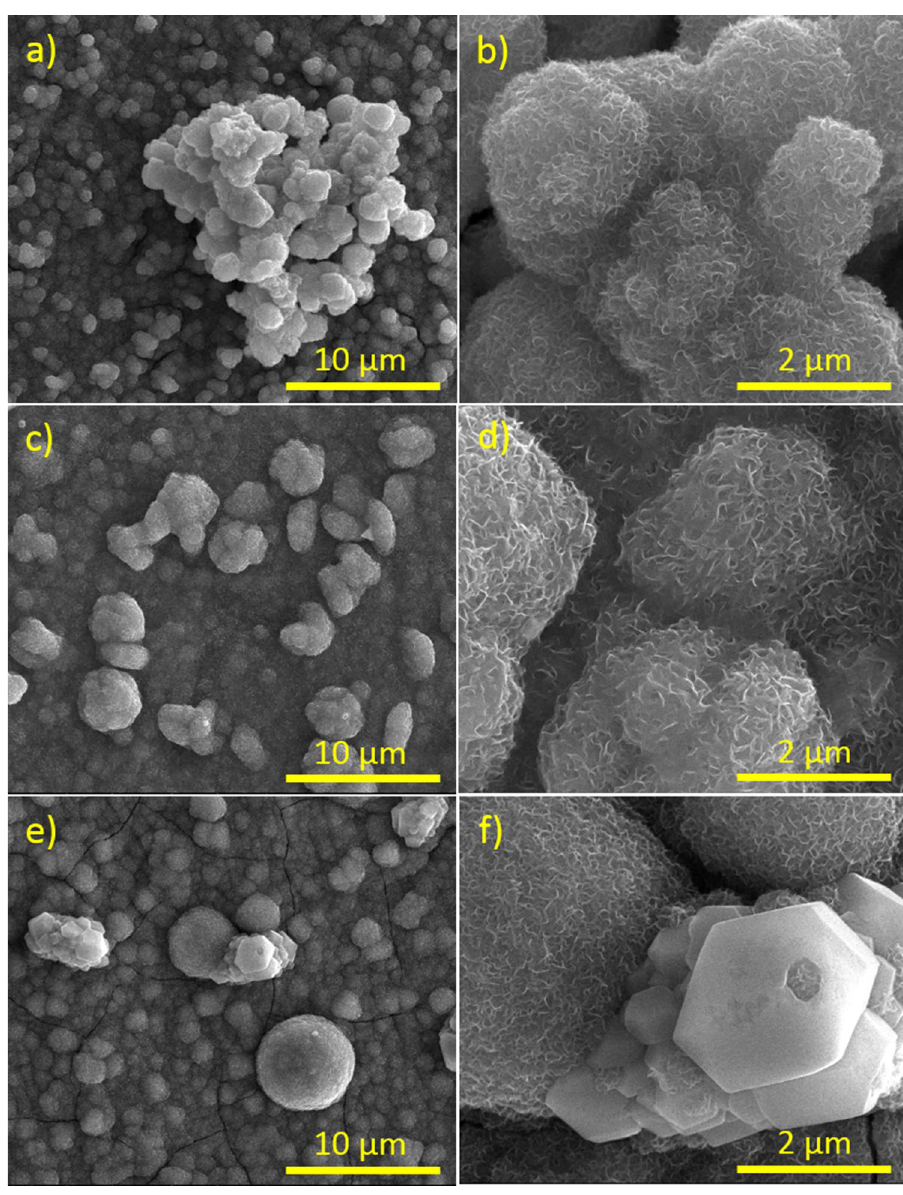
Figure 1. SEM images of samples: ( a,b ) TiO 2 /CoMoO 4 , ( c,d ) TiO 2 /SrMoO 4 , ( e,f ) TiO 2 /SrMoO 4 /CoMoO 4 .